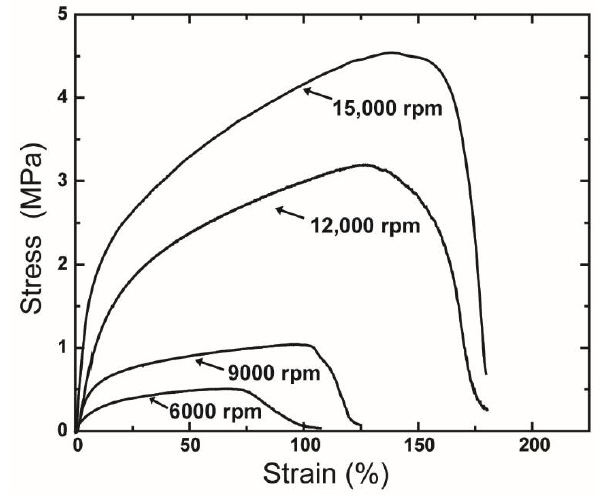
Figure 9. Tensile stress-strain curves of the fiber mats produced under various rotation speeds. Centrifugal spinning condition: polymer solution concentration, 10 wt %; needle inner diameter, 160 μm; collection distance, 10 cm. Table 2. Mechanical properties of rPET fibers prepared under various rotation